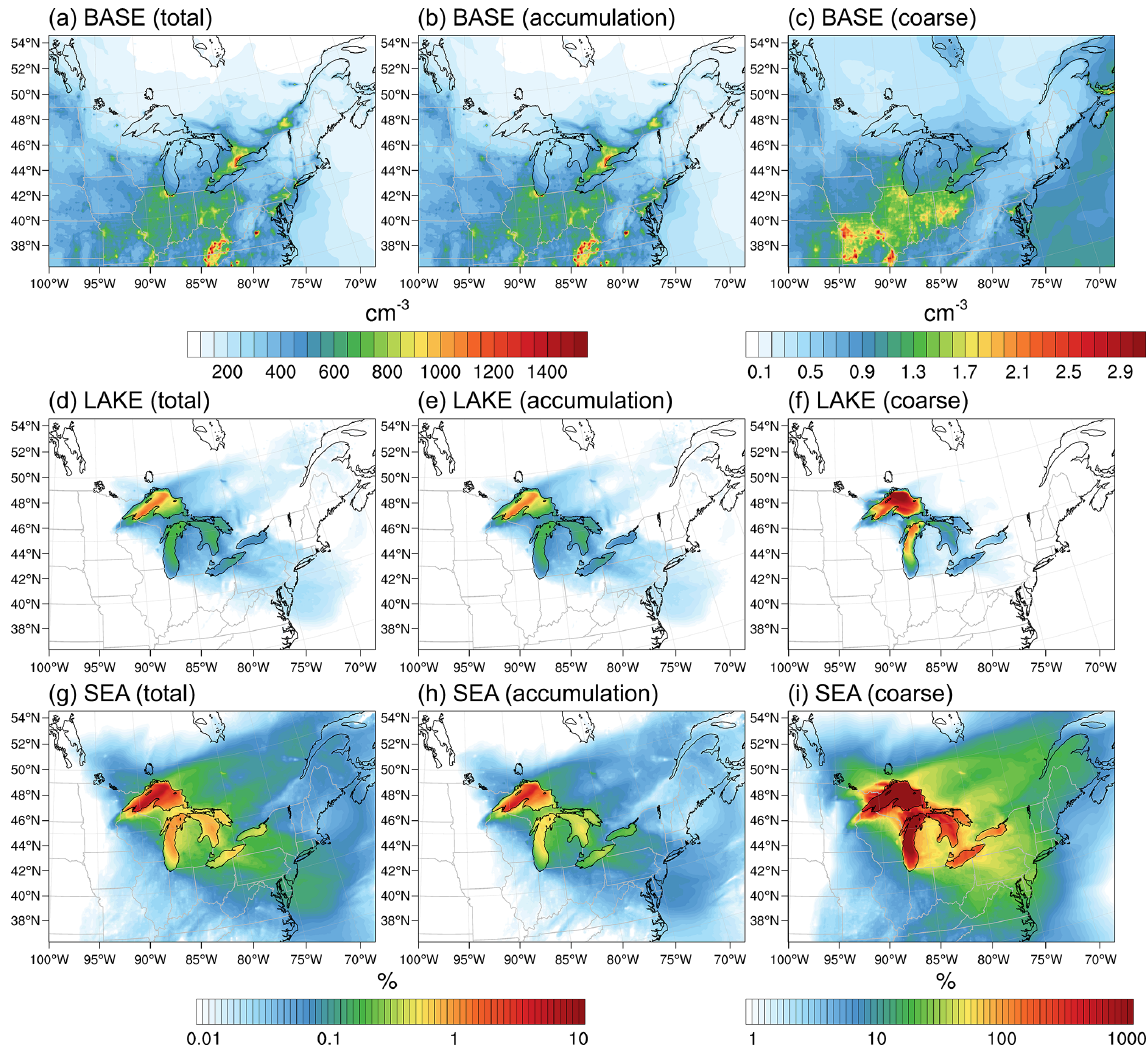
Figure 8. Average (10–30 November 2016) (a–c) total, accumulation-mode, and coarse-mode surface layer aerosol number concentrations in the BASE scenario and their corresponding percent increase in the (d–f) LAKE and (g–i) SEA scenarios. Notice the different color map for coarse-mode number